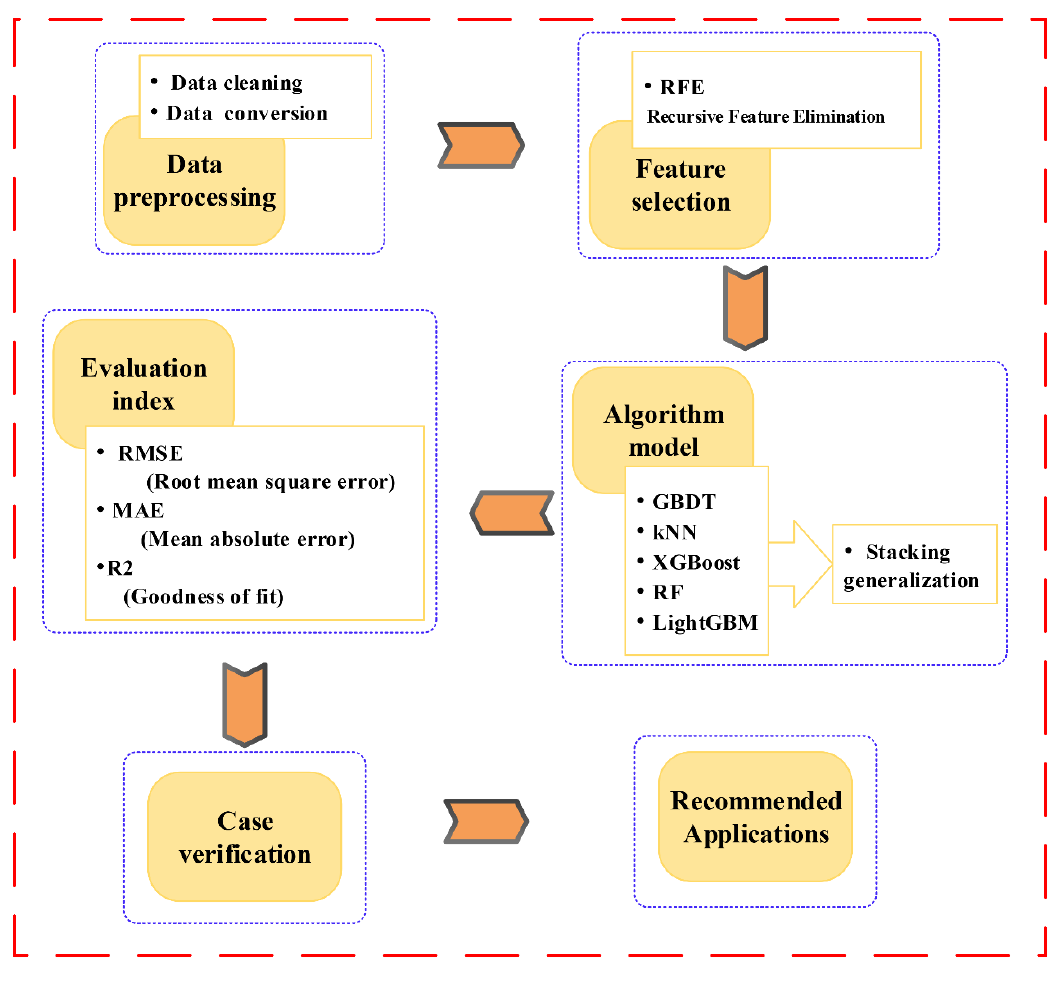
Figure 2. Technical framework of the article.